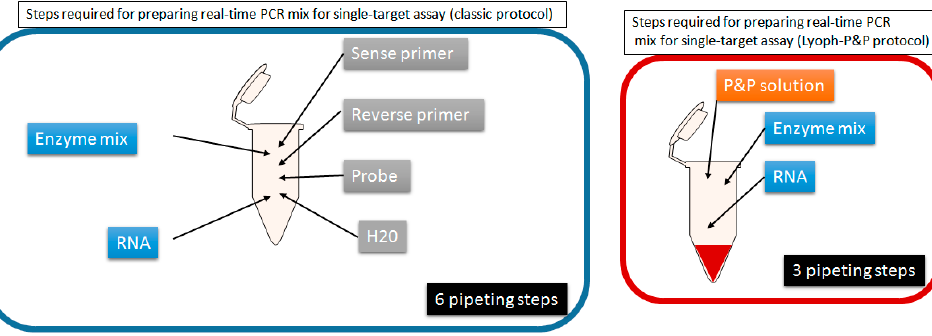
Figure 2. PCR/RT-PCR mix preparation using the extemporaneous formulation versus Lyoph-P&P Figure 2. PCR / RT-PCR mix preparation using the extemporaneous formulation versus Lyoph-P&P method.